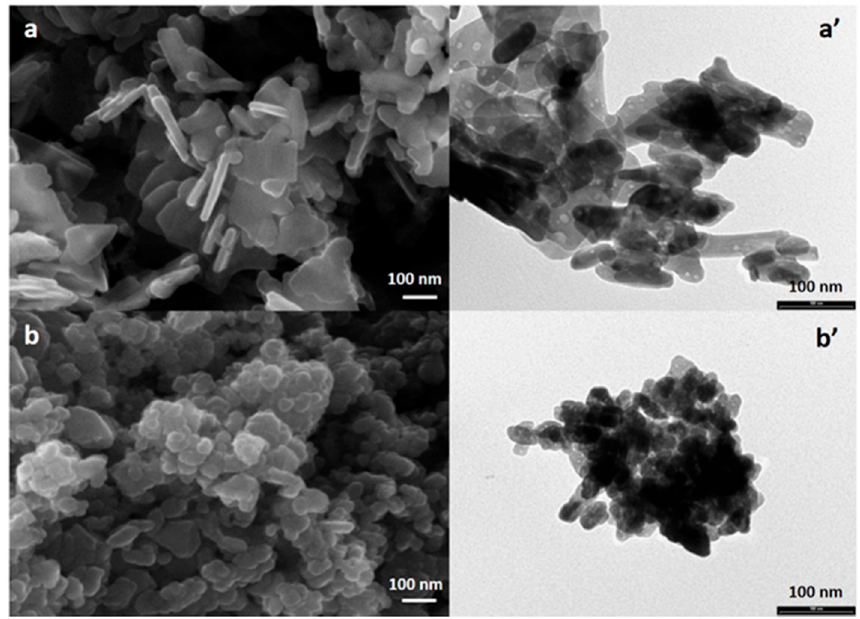
Figure 2. FE-SEM and TEM images of samples non-biogenic ( a , a’ ) and biogenic ( b , b’ ) ZnO-NPs.